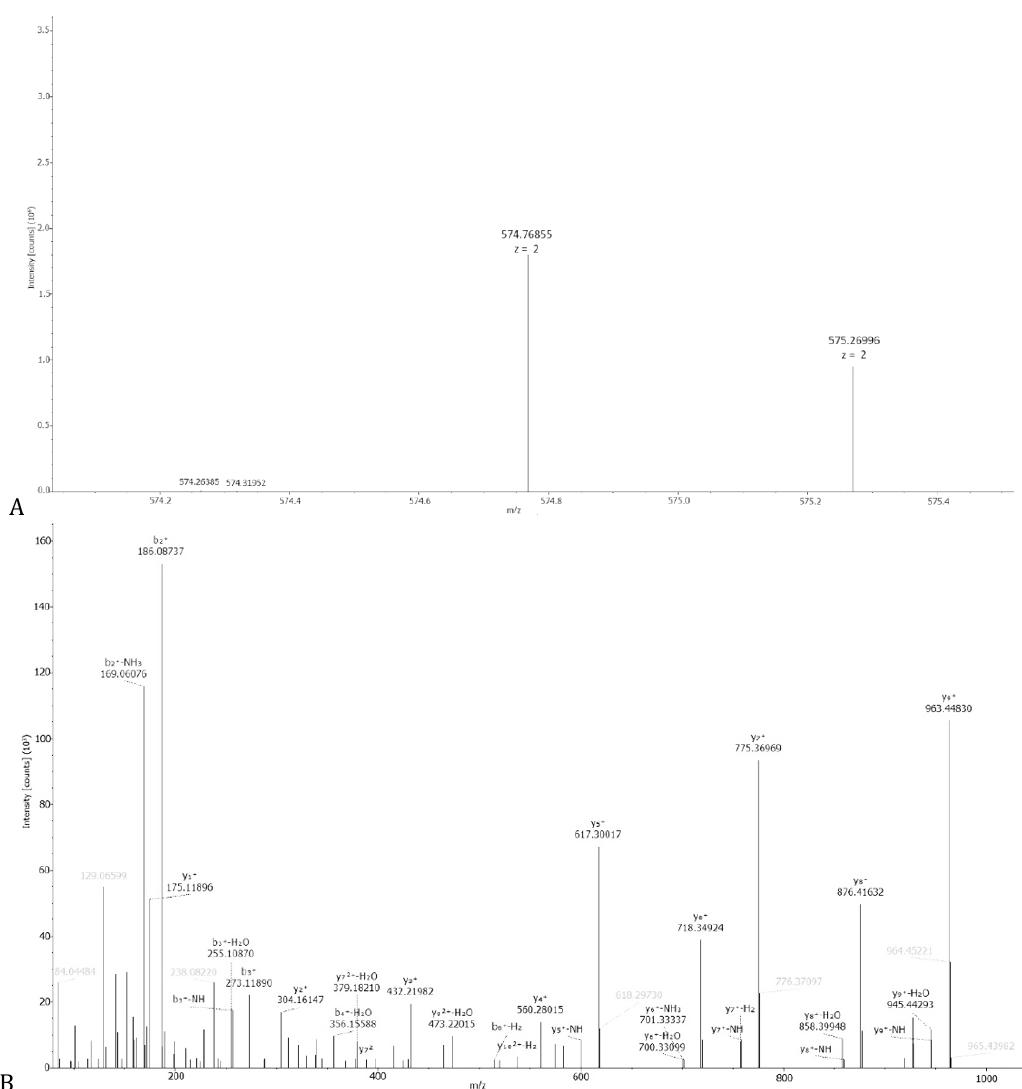
Figure 4. MS spectra of peptide number 2 of the pH 4 fraction of R. communis seed protein hydrolysate. MS 1 identifies the isotopic pattern of the peptide ion (a), whereas MS 2 identifies the b + and y + ions from the peptide fragmentation data